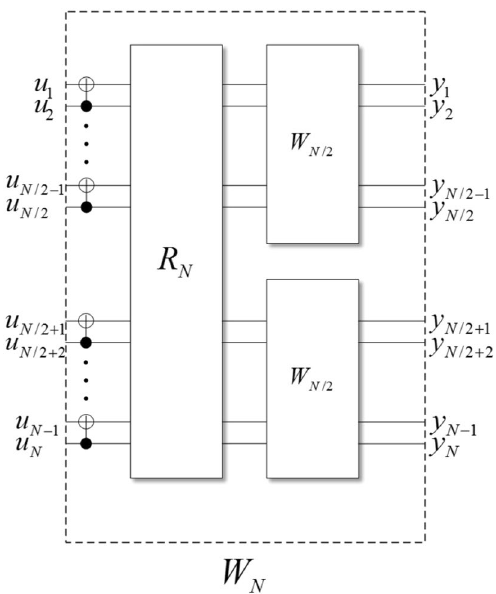
Figure 2. Channel polarization. R N is the bit-reversal operation. When N = 1 , W 1 is the original channel W